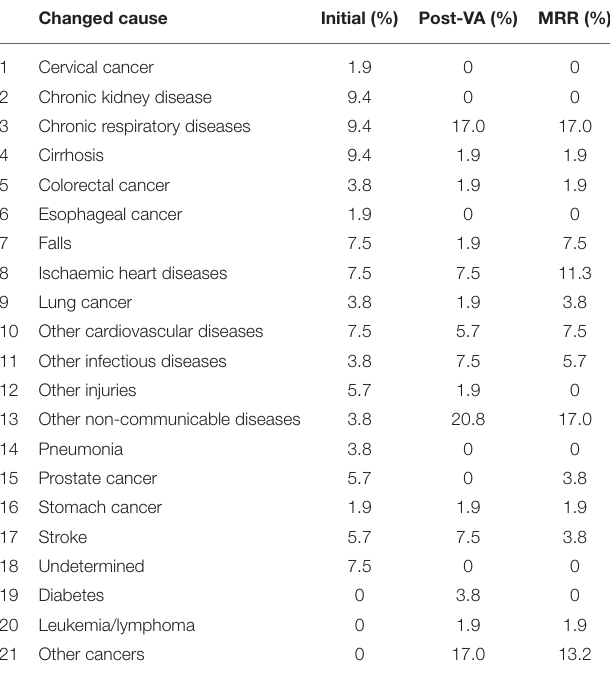
TABLE 9 | The distribution of UCOD for 53 misclassified cases (based on initial diagnosis). Changed